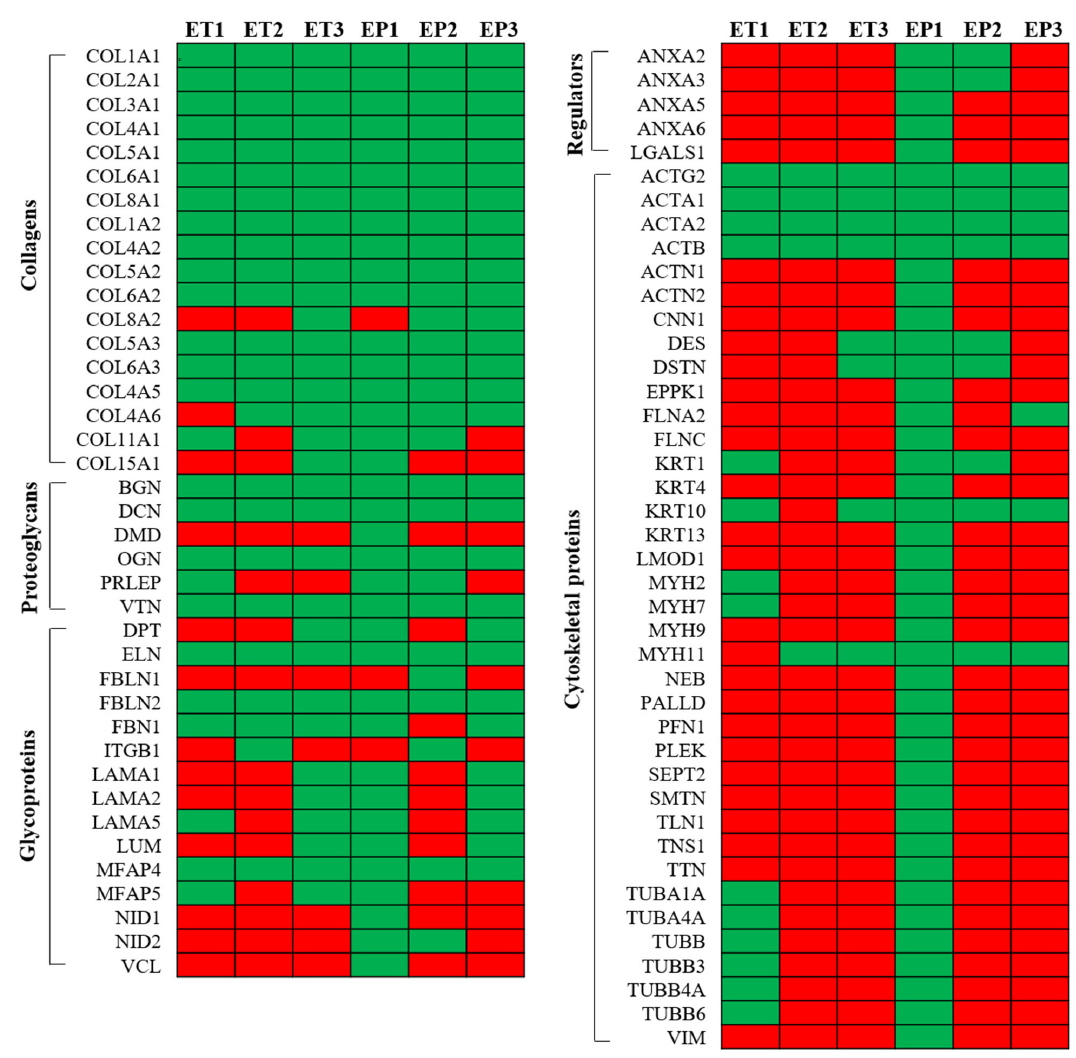
Figure 6. Proteomic study. Overview of the main detected proteins in esophageal tubules (ETs) and patches (EPs) decellularized with Protocols Nos. 1 (ET1, EP1), 2 (ET2, EP2) and 3 (ET3, EP3). (Green: positive protein expression; red: negative protein expression.)